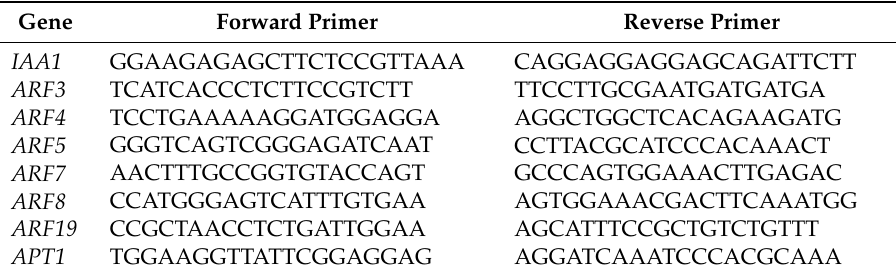
Table 1. DNA primer sequences used for